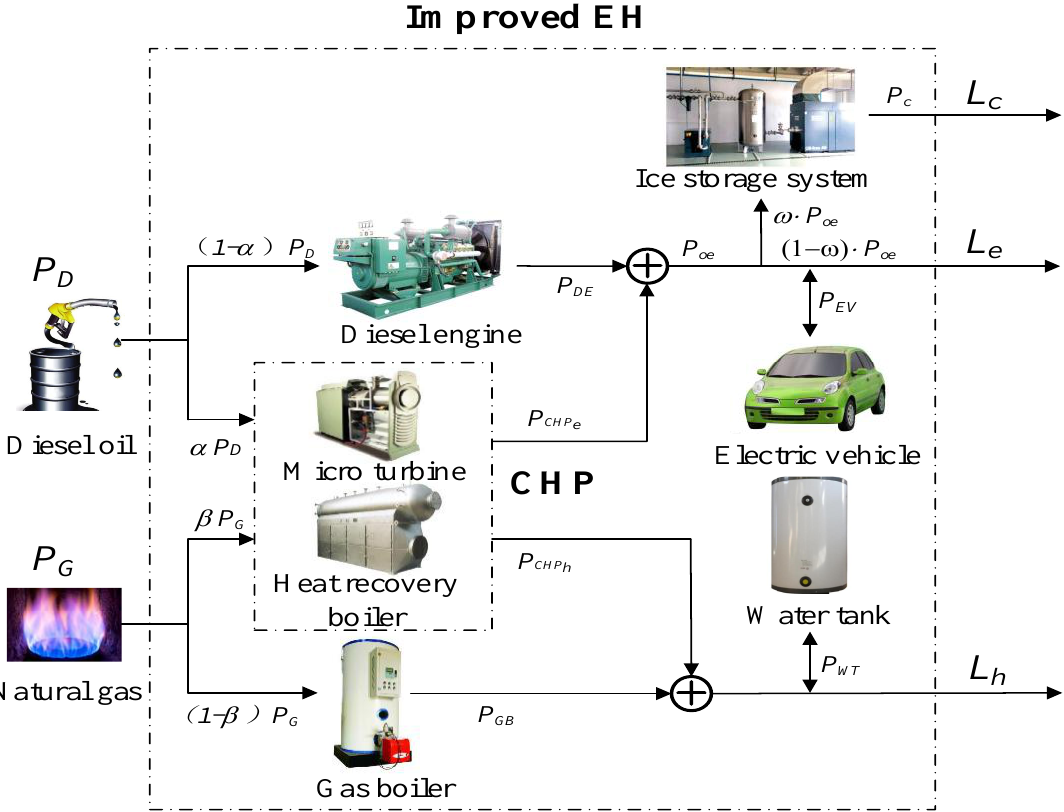
Figure 2. An improved Energy Hub model.